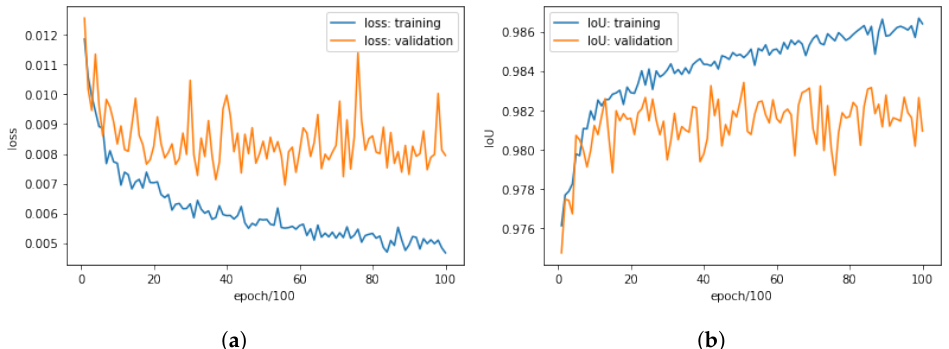
Figure 4. Fine-tuning CROP with the training dataset (80%: 68) and the validation dataset (20%: 18) of Data_Pears2 , so that the best IoU for the validation data was 0.983 achieved at epoch 5100. ( a ) Losses for epoch 100–10,000. ( b ) IoUs for epoch 100–10,000.